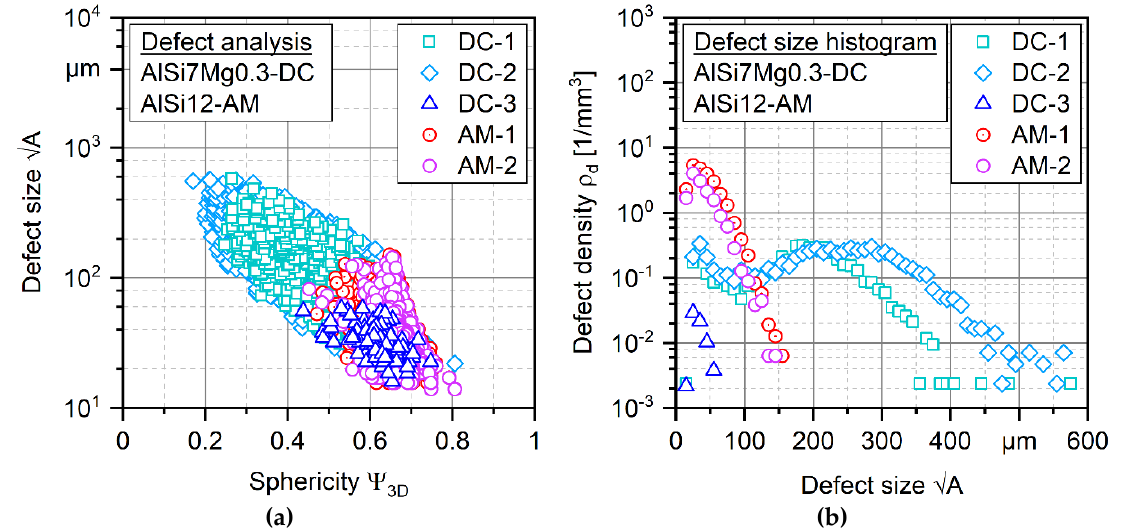
Figure 6. ( a ) Defect size √𝐴 and sphericity Ψ 3𝐷 and ( b ) histograms of the defect size distribution for die-cast (DC) and additively manufactured (AM) alloy (defect density is equal to the frequency of counts per class and per volume). Table 3. Hardness and quasi-static properties of die-cast (DC) and additively manufactured (AM) alloy AlSi7Mg0.3 and